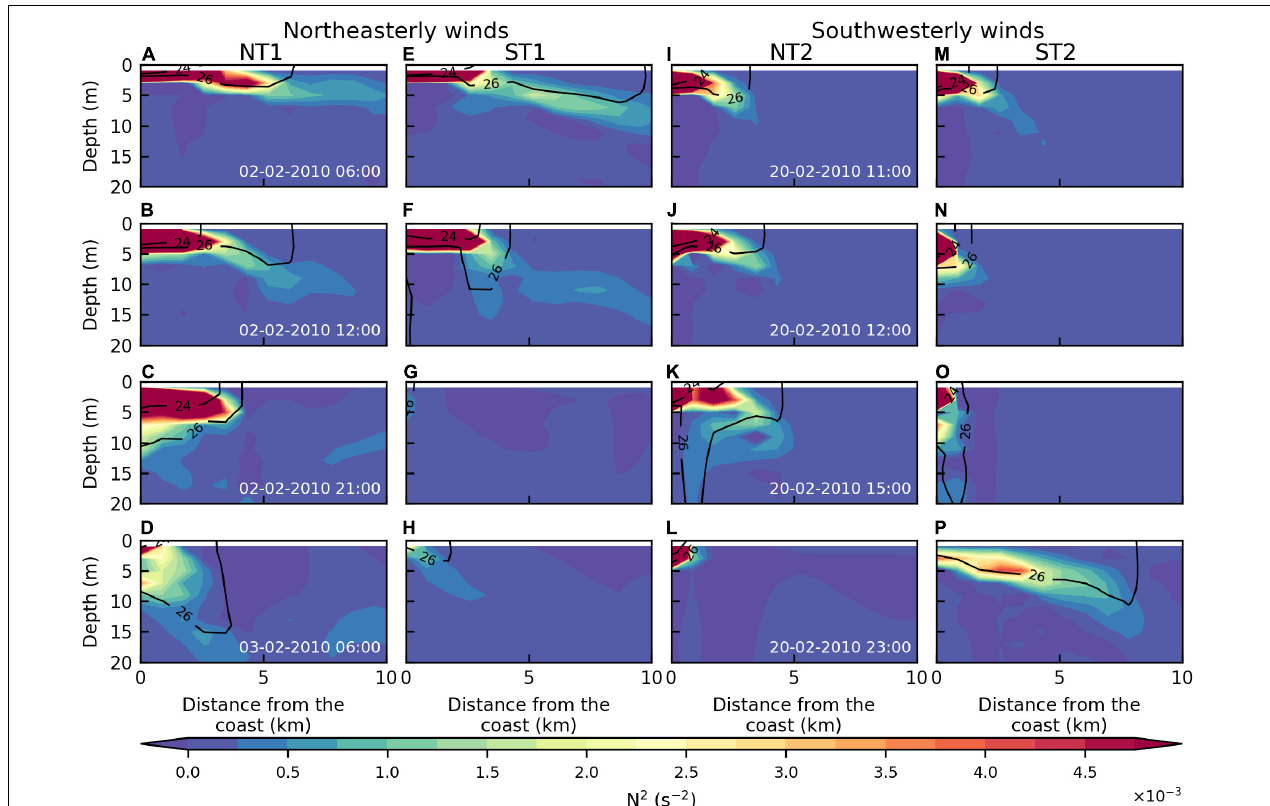
FIGURE 11 | Vertical variability of Brunt–Väisälä Frequency (10 − 3 s − 2 ) with density contours in transects (A–D) NT1 and (E–H) ST1 during northeasterly winds and (I–L) NT2 and (M–P) ST2 during southwesterly